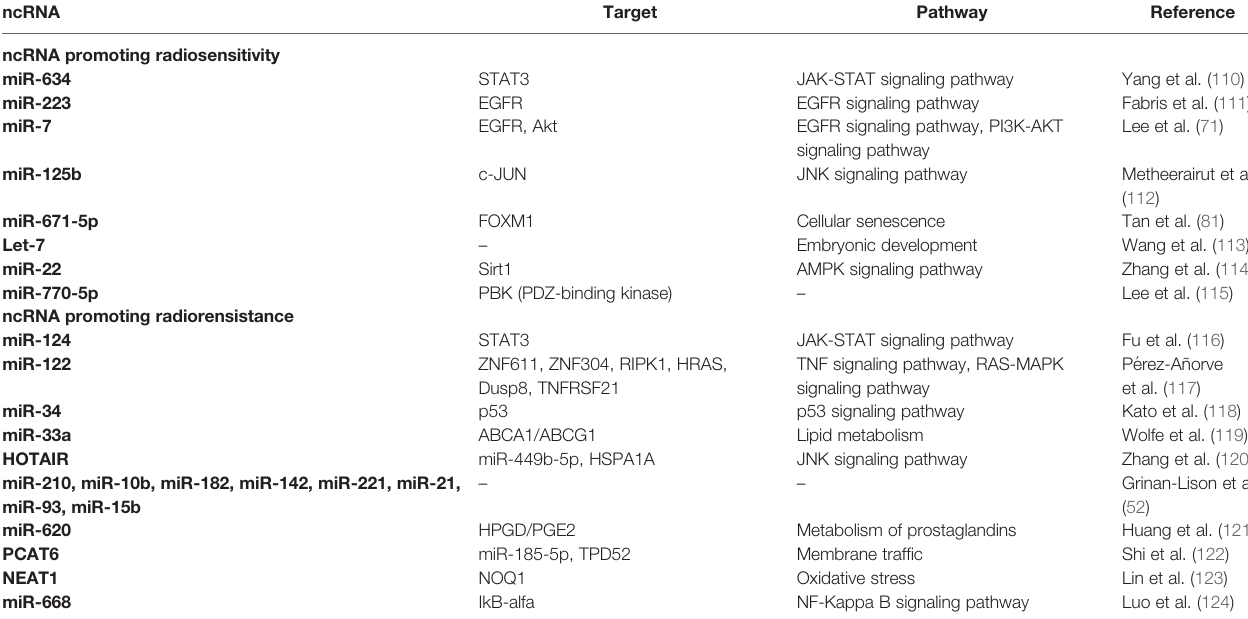
TABLE 1 | Reported ncRNAs that regulate cell signaling, cell metabolism, and in fl